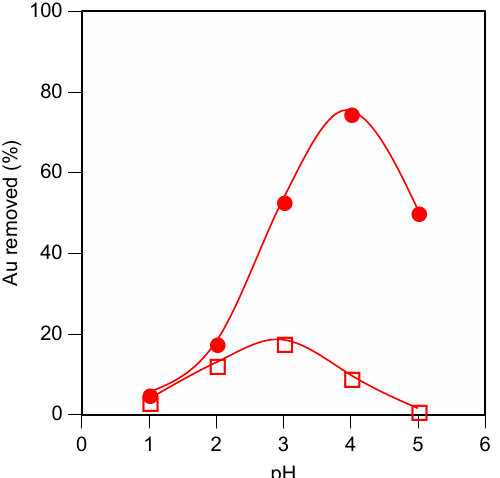
Figure 3. Effect of pH on gold removal using C. krusei. Symbols, circle: contact 72 h (biomineralization), square symbols: 1 h (biosorption).